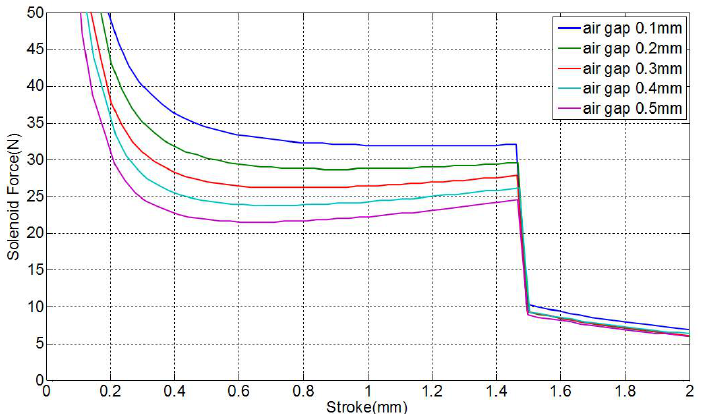
Figure 13. Simulation results for the air gap.